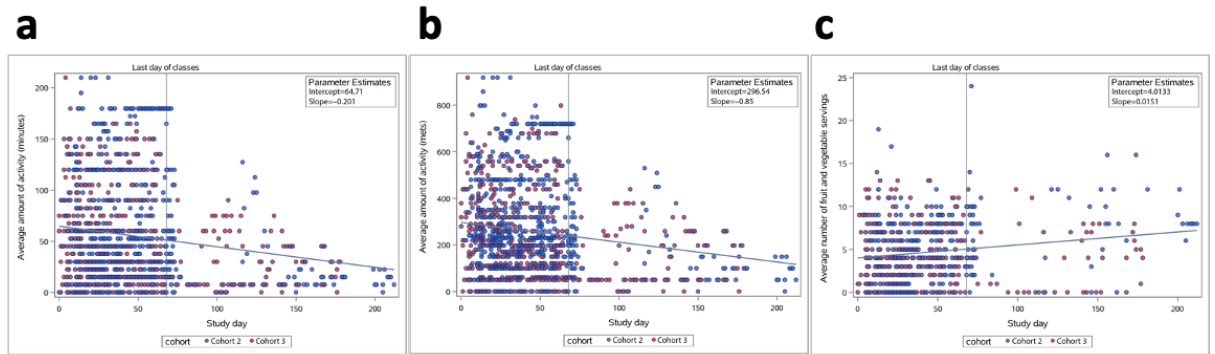
Figure 10. Diary entry values recorded over the study period: (a) activity data (in minutes) over time; (b) activity data (in METS) over time; (c) fruit and vegetable servings over time. METS: metabolic